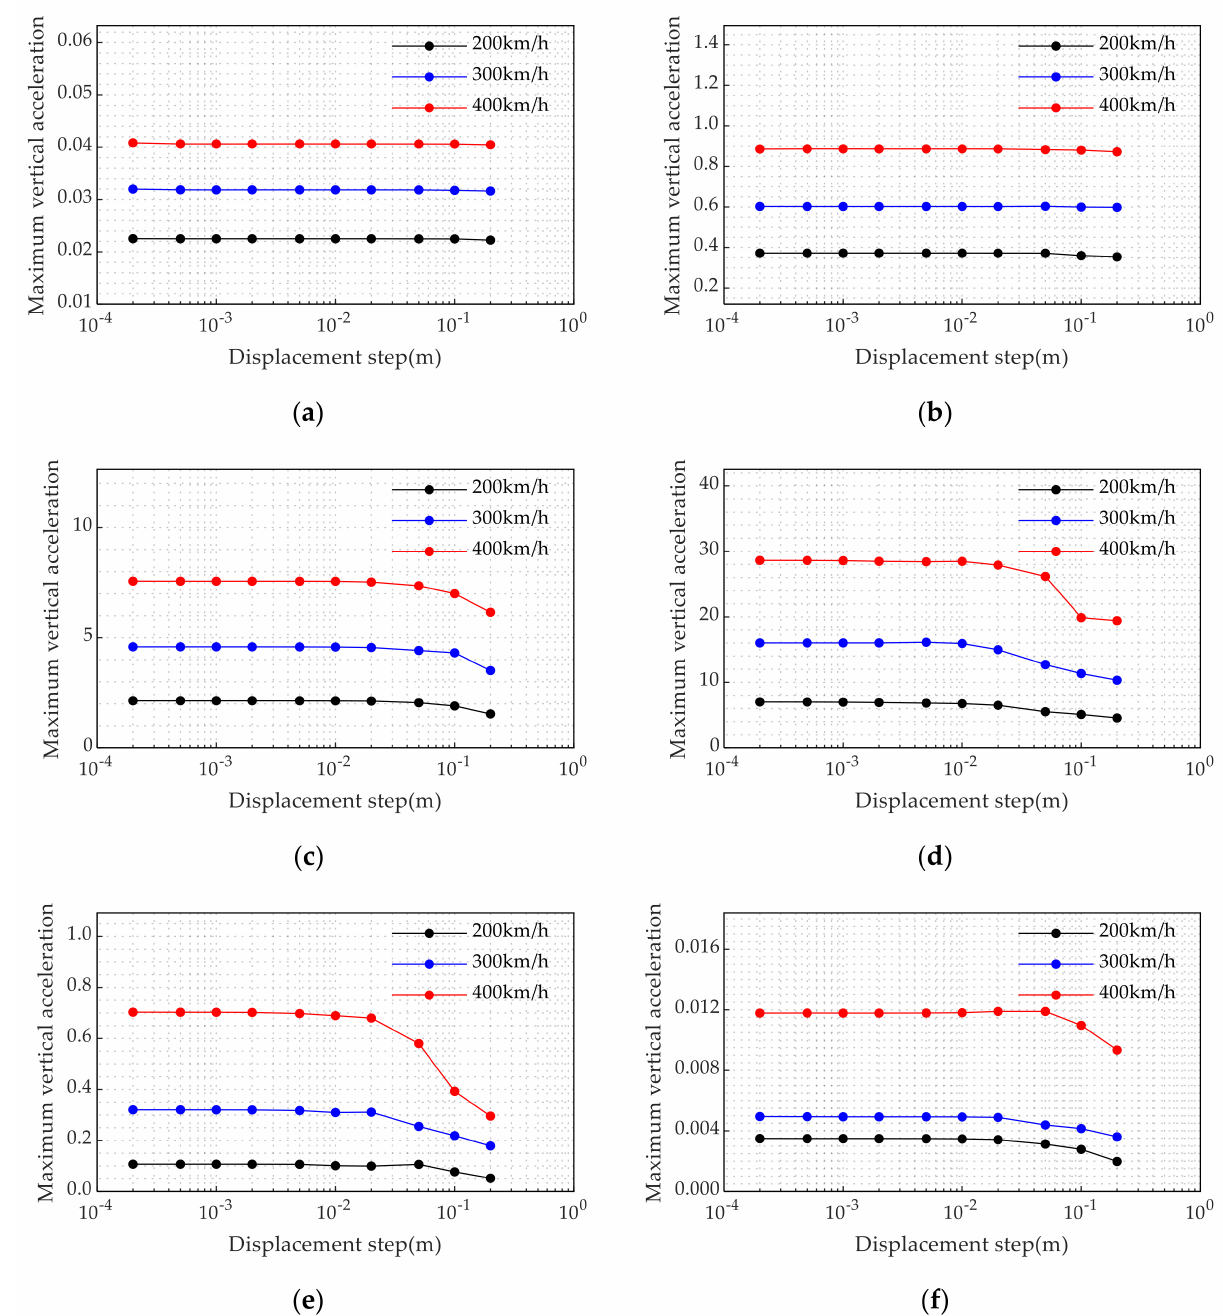
Figure 11. The effect of the displacement step on the maximum vertical acceleration of the: ( a ) car body; ( b ) bogie; ( c ) wheel-sets; ( d ) rail; ( e ) track slab; ( f ) bridge under different